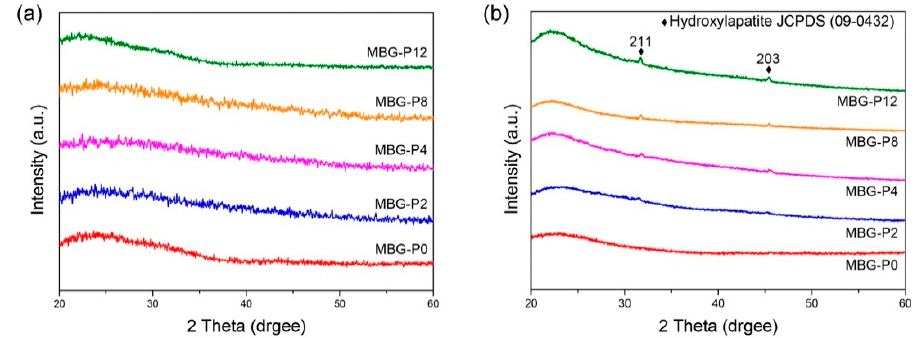
Figure 4. XRD patterns of MBG adding different molecular weights of PEG ( a ), and the bioactivity analysis results (XRD patterns) of MBG immersed in SBF for 24 h ( b